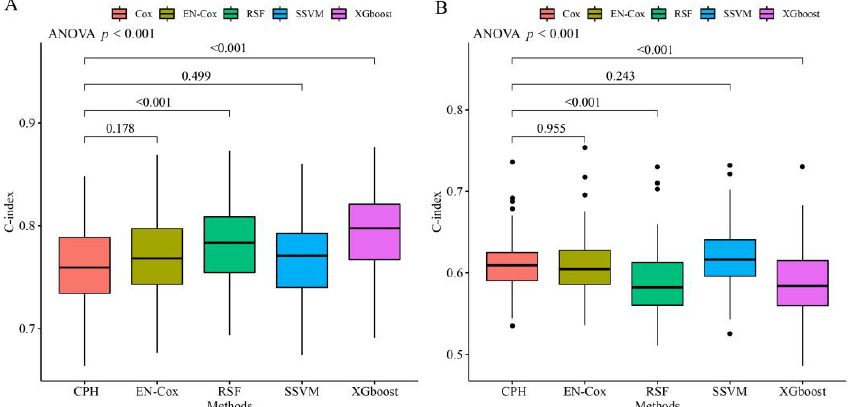
Figure 2. Comparison of C-index between CPH and ML algorithms for all-cause death ( A ) and first